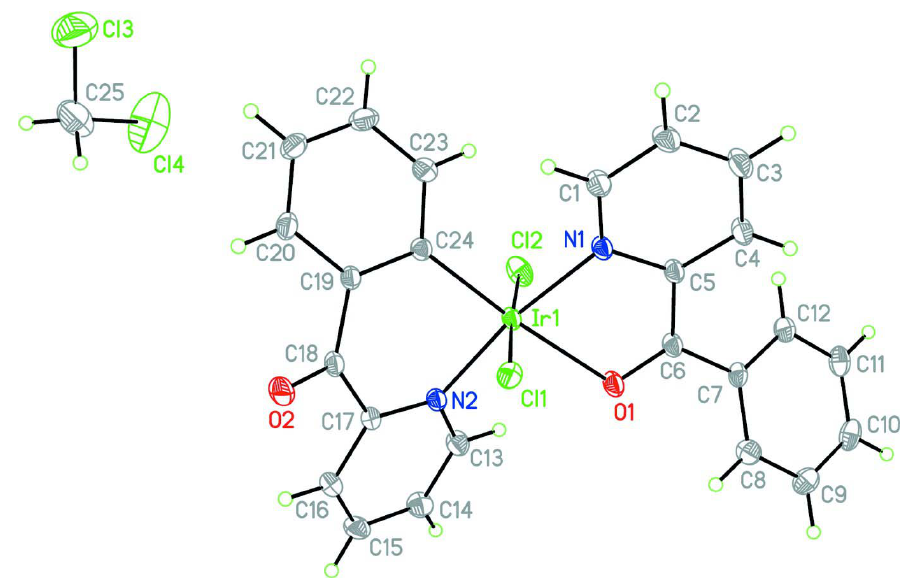
Figure 1 A view of the molecular structure of the title compound with displacement ellipsoids shown at the 50% probability level. trans -(2-Benzoylpyridine- κ 2 N , O )dichlorido[2- (2-pyridylcarbonyl)phenyl- κ 2 C 1 , N ]iridium(III) dichloromethane